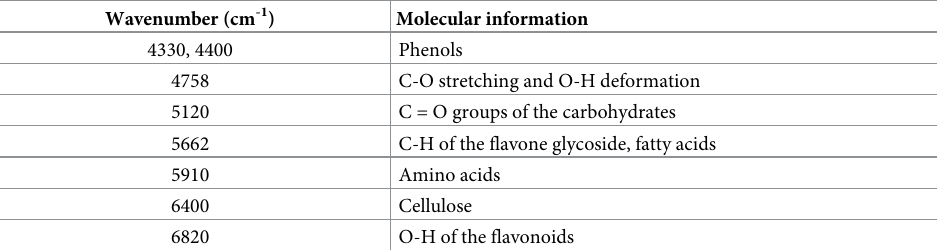
Table 2. Peak positions and tentative assignments of the major NIR bands of